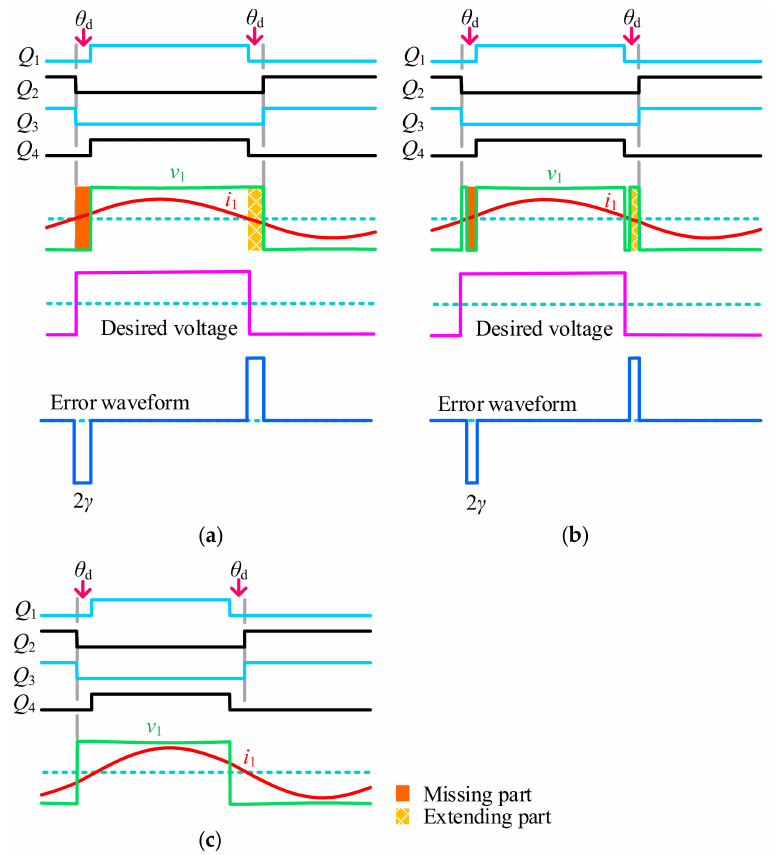
Figure 2. Dead-time effect of one active bridge WPT system. ( a ) Dead time is inserted when i 1 > 0; ( b ) Dead time is inserted during the zero-crossing point of i 1 ; ( c ) Dead time is inserted when i 1 <